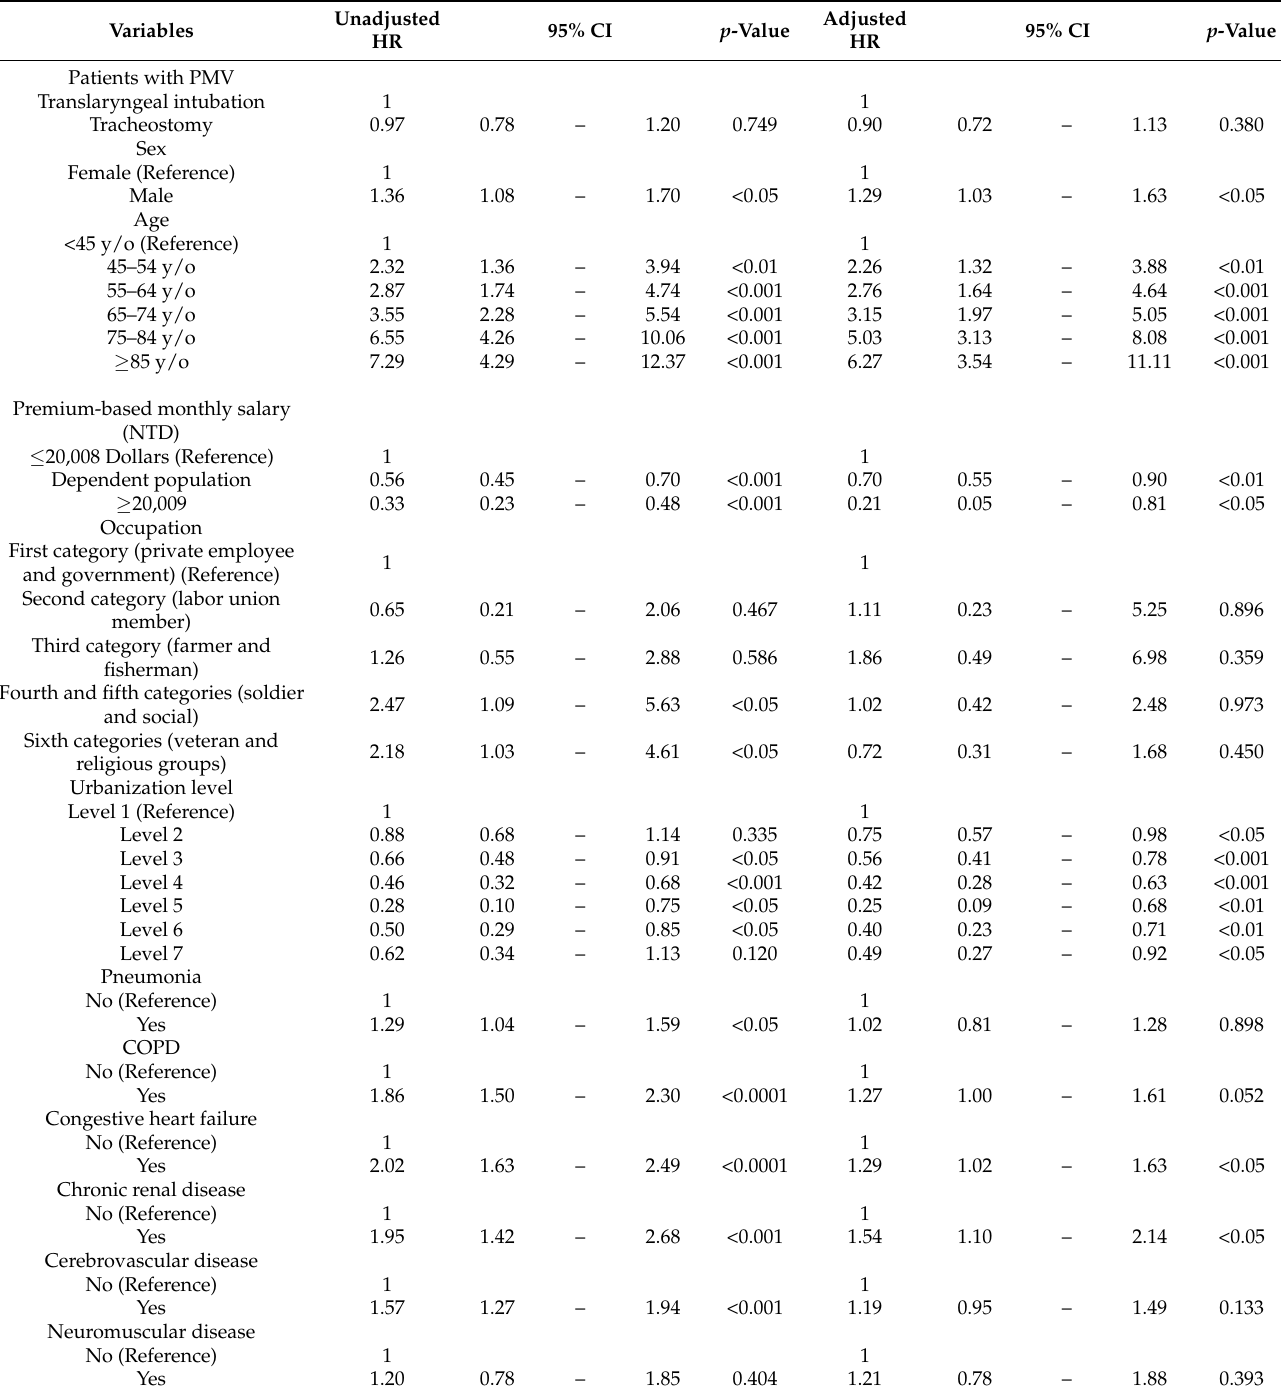
Table 4. Cox regression model of survival analysis in patients with